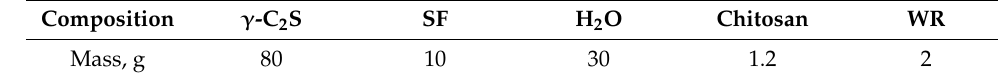
Table 3. Mixture proportion.